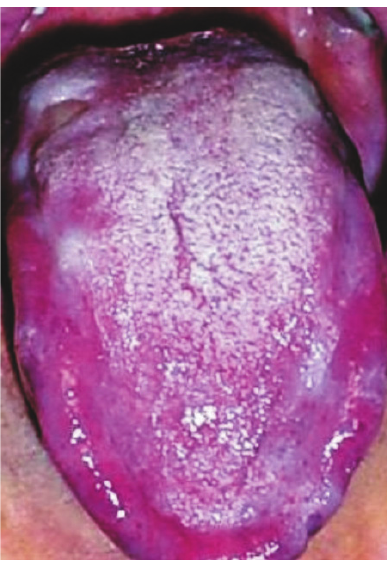
Figure 11 - Erosive non-striated oral lichen planus affecting the dorsum of the